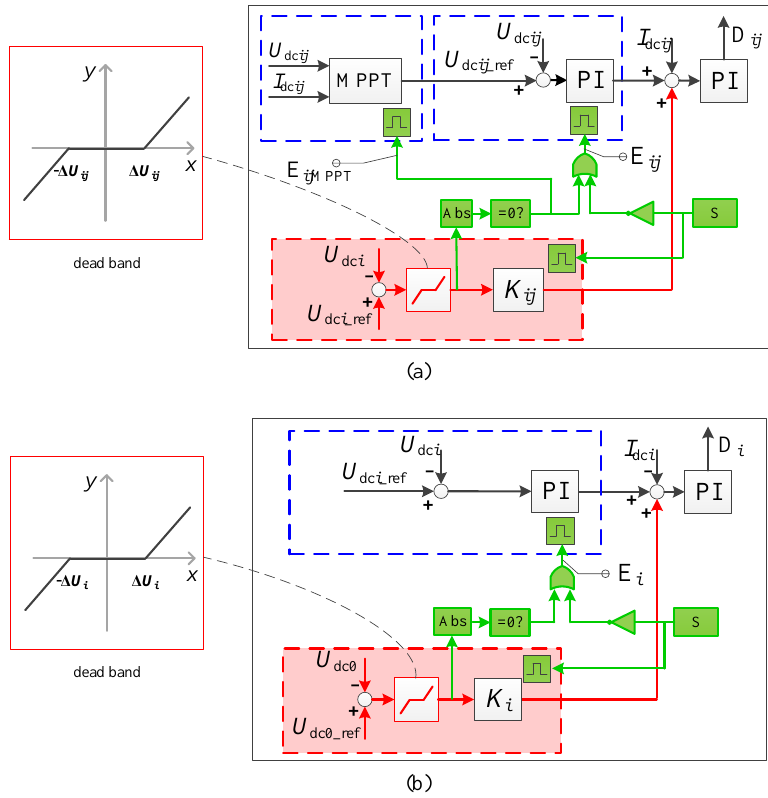
Figure 10. ( a ) Improved controller design of boost converter ij ; ( b ) Improved controller design of full-bridge isolated DC/DC converter i .